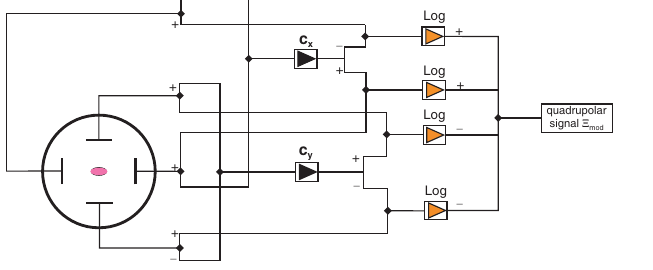
FIG. 2. Graphical representation of the modified log ratio technique.